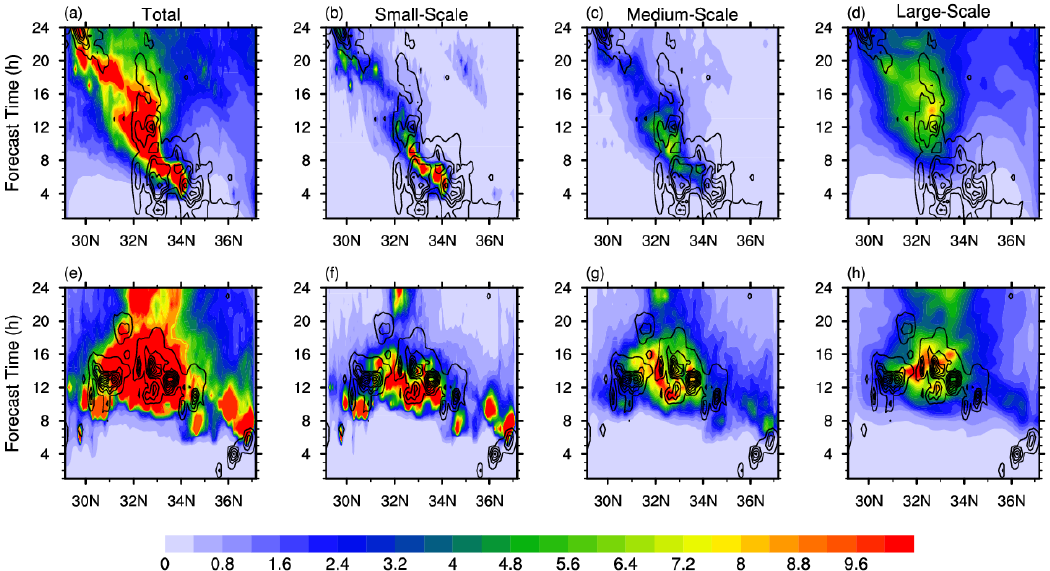
Figure 10. Hovmöller diagrams (time-latitude) of the RMDTE (shaded) and the precipitation (contour) at different scales in ( a – d ) the SF case and ( e – h ) the WF case.